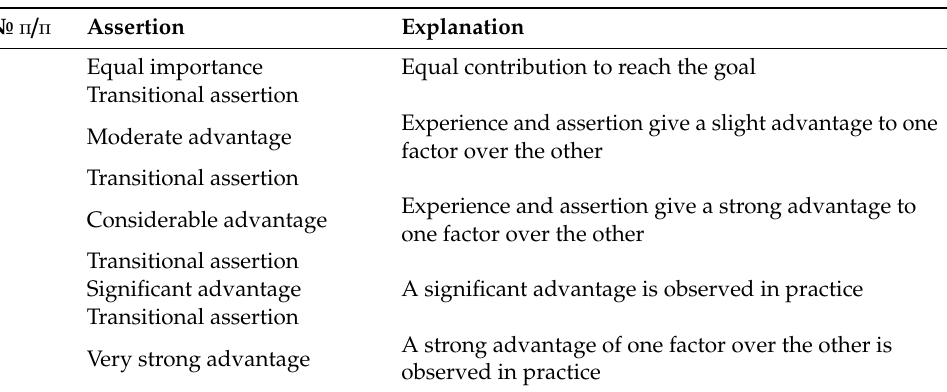
Table 1. Relative importance